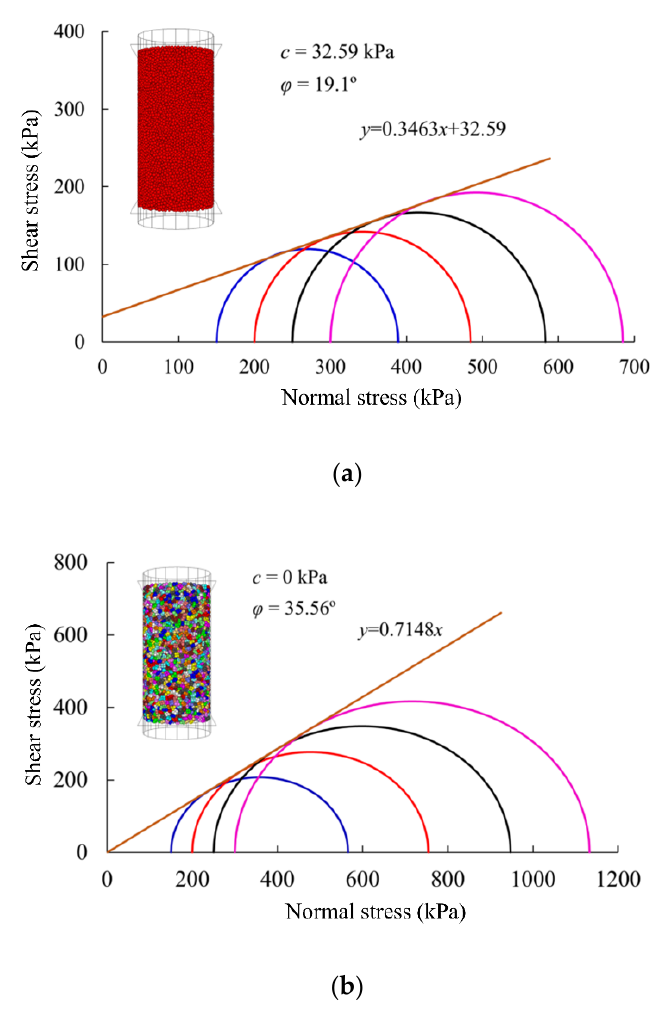
Figure 4. Mohr circle of the triaxial compression test on: ( a ) clay; ( b ) sand.